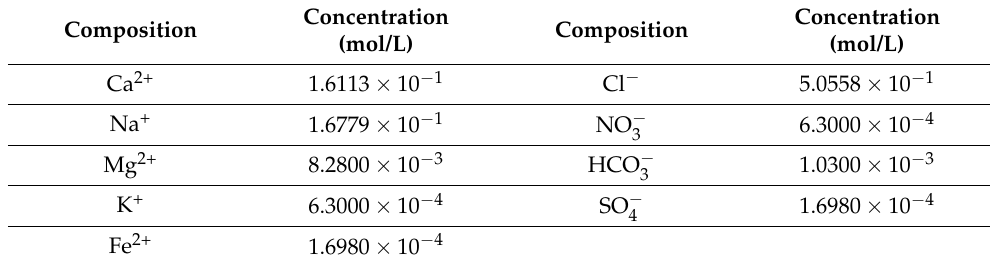
Table 3. Brine composition [11].